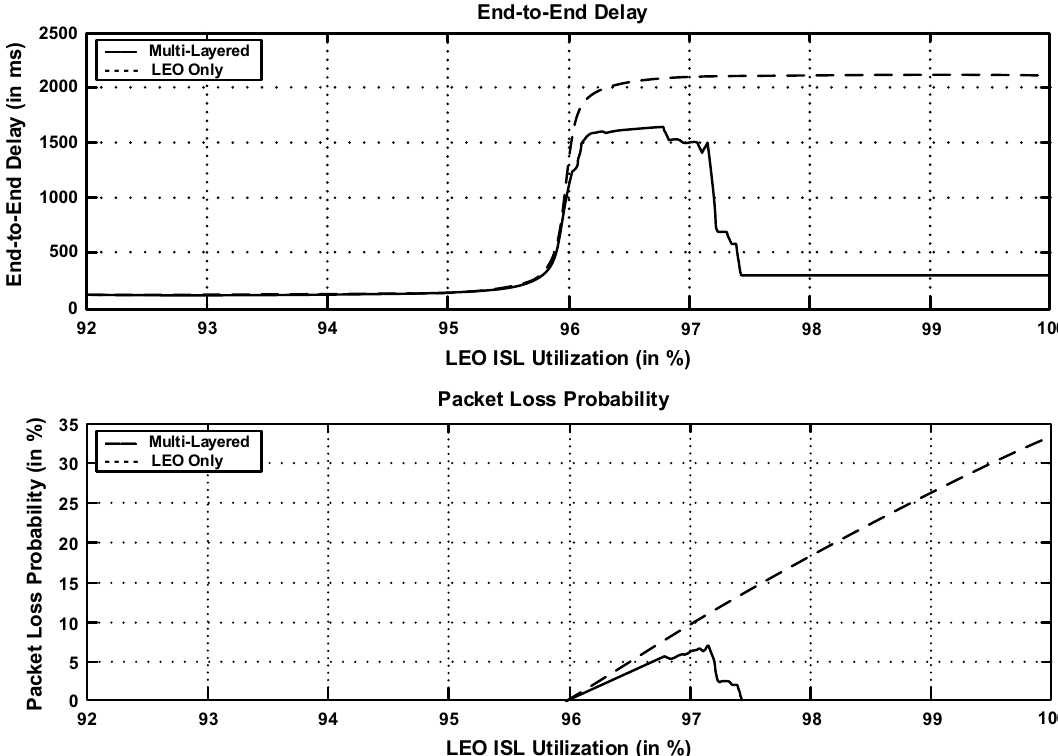
Figure 5. Delay and packet loss probability performance of multi-layered satellite network and an LEO satellite